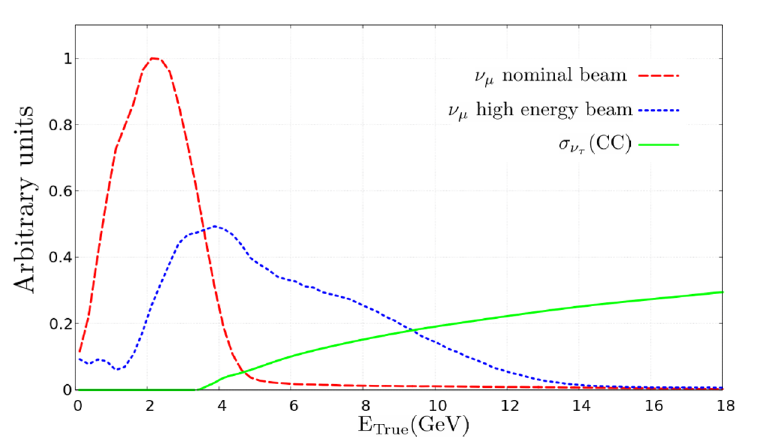
Figure 1 . Comparison between the nominal ν µ flux and the HE flux as a function of the neutrino energy, in arbitrary units. Both curves are shown for neutrino mode only; the comparison is qualitatively similar for the antineutrino running mode fluxes. For comparison, the ν τ CC cross section is also